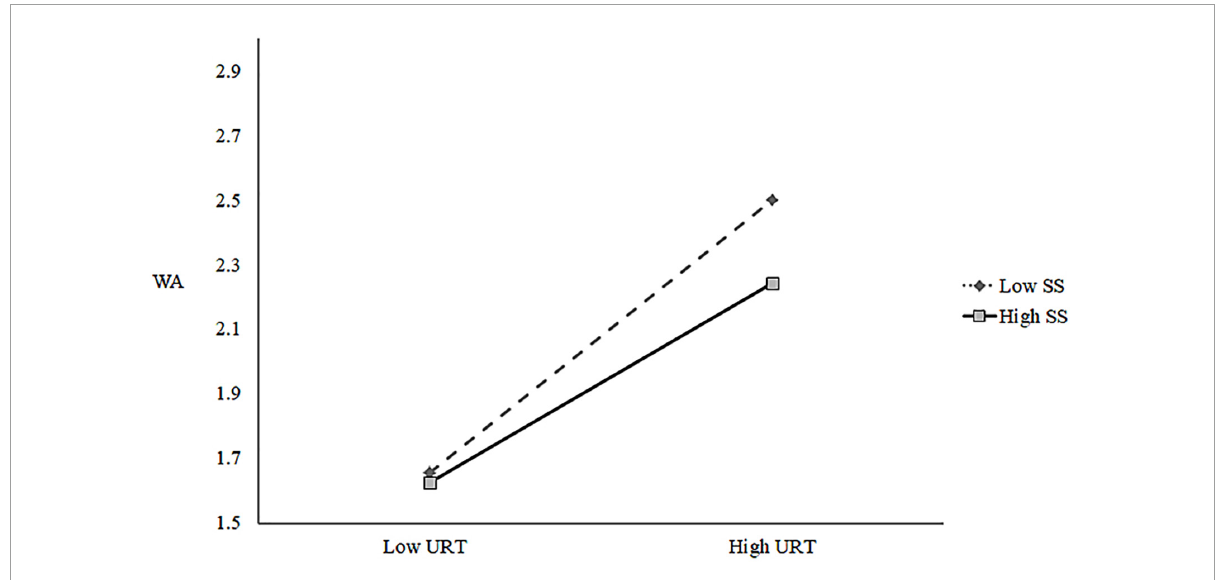
FIGURE2 Moderating effect of SS on relationship between URT and